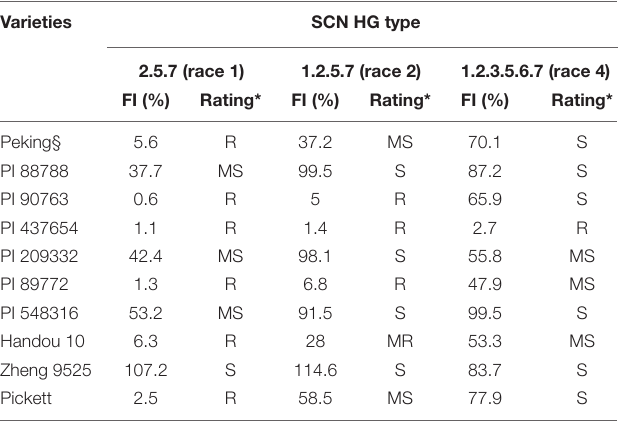
TABLE 1 | Evaluation of Handou 10, Zheng 9525, and eight differential cultivars for resistance to three HG types of soybean cyst nematode (SCN). Varieties SCN HG